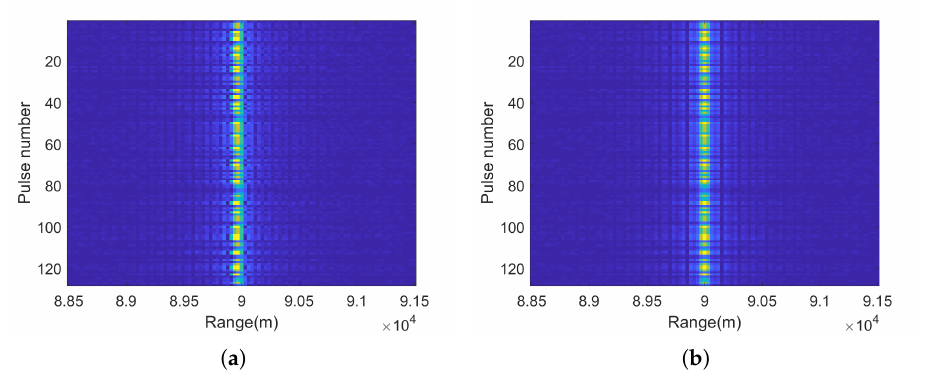
Figure 9. Results of signal after compensation. ( a ) Result after compensation of irregular RCM; ( b ) Result after compensation of irregular RCM and range-Doppler